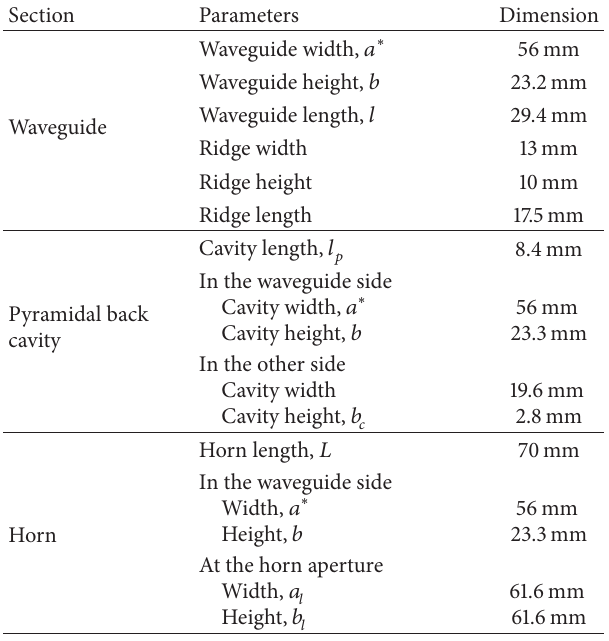
Table 2: The double-ridged horn antenna parameters.